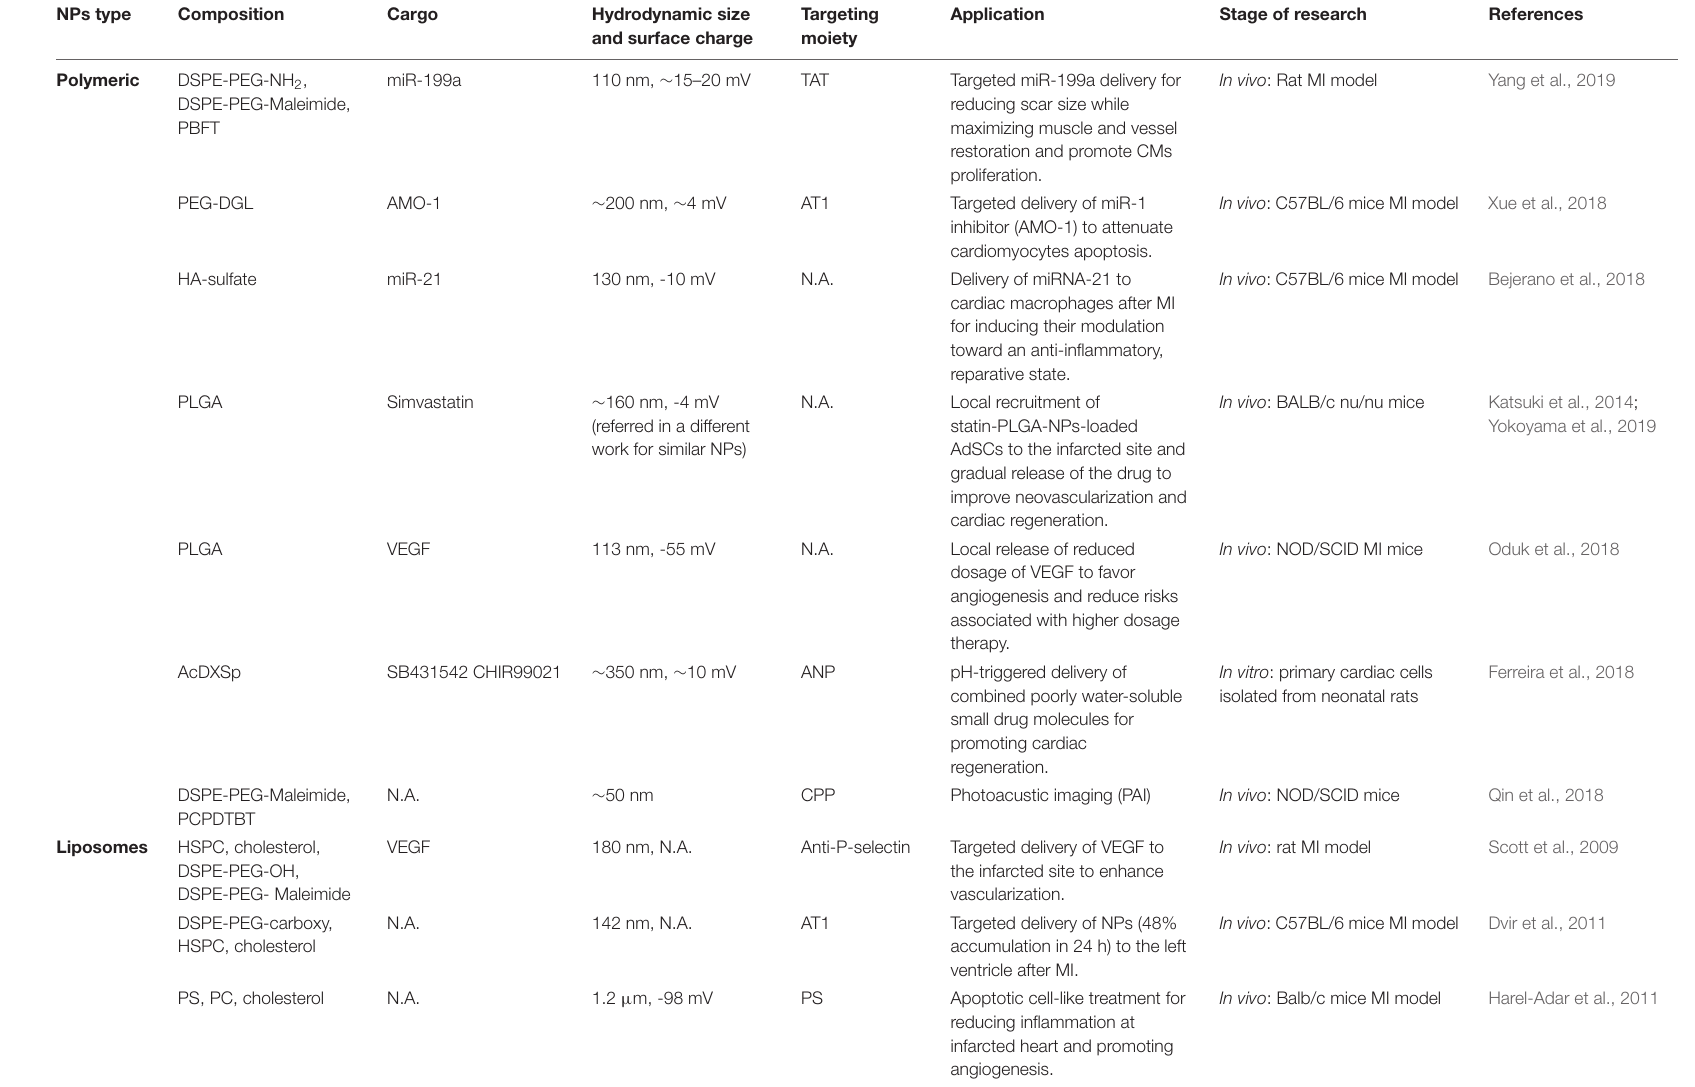
TABLE 3 | NPs for cardiac